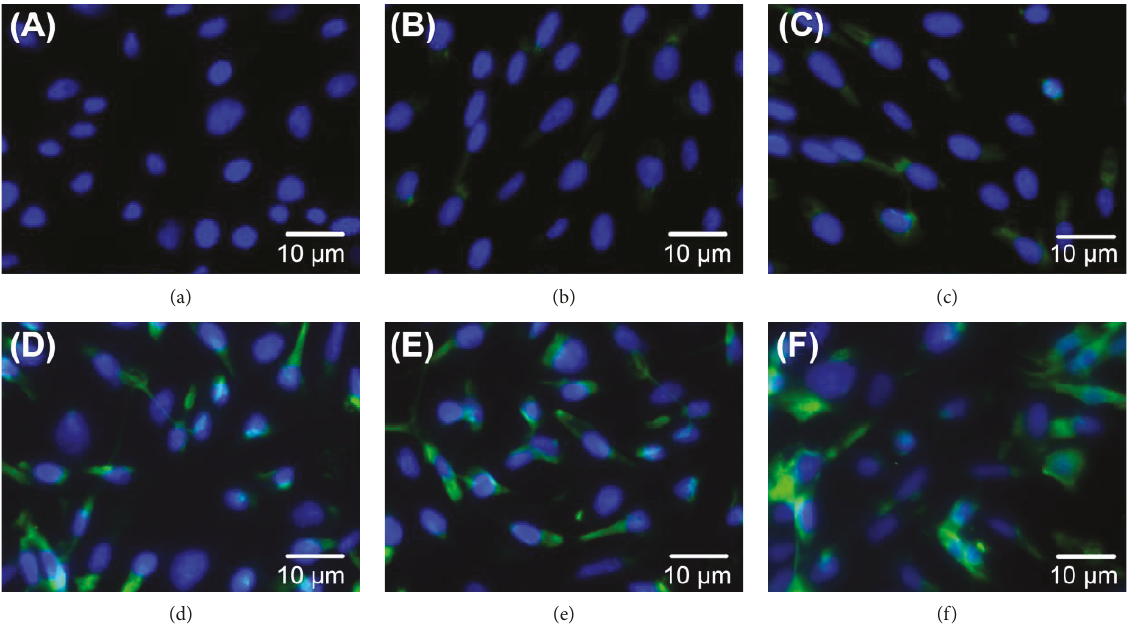
Figure 5: Recruitment of ALB in the cytoplasm of BMMSCs on the 21st day. (a) Noninduced BMMSCs, (b) HGF, (c) HGF+SB203580, (d) HGF+zebularine, (e) HGF+zebularine +SB203580, and (f) primary rabbit hepatocytes. Cells analyzed by immuno fl uorescence with ALB (green) as a hepatocyte marker and DAPI to stain nuclear (blue). There were (18.67 ± 6.19)%, (26.71 ± 7.31)%, (70.04 ± 6.09)%, (71.82 ± 5.67)%, and (89.36 ± 5.38)% positive cells in HGF, HGF+ SB203580, HGF +zebularine, HGF+zebularine + SB203580, and primary rabbit hepatocyte groups, respectively.